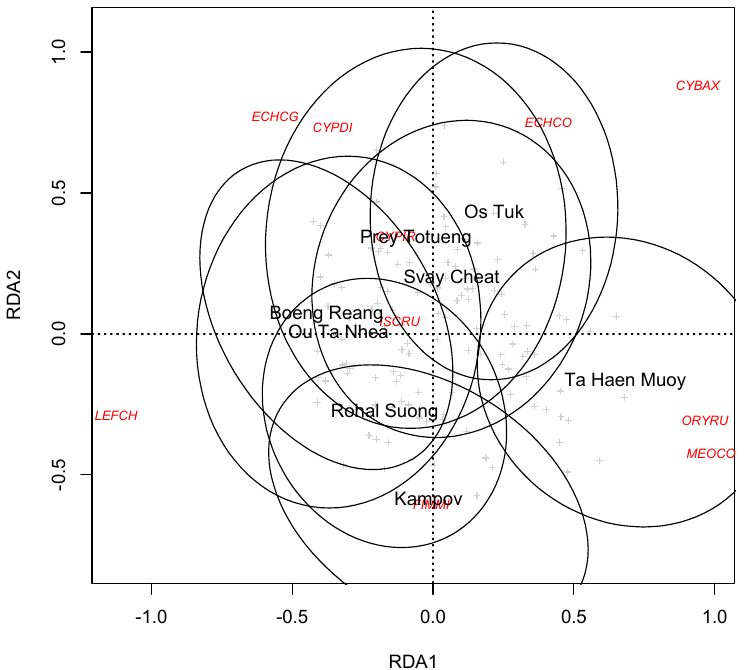
Figure 3. Redundancy analysis (RDA) of weed species as reported by farmers in their fields.